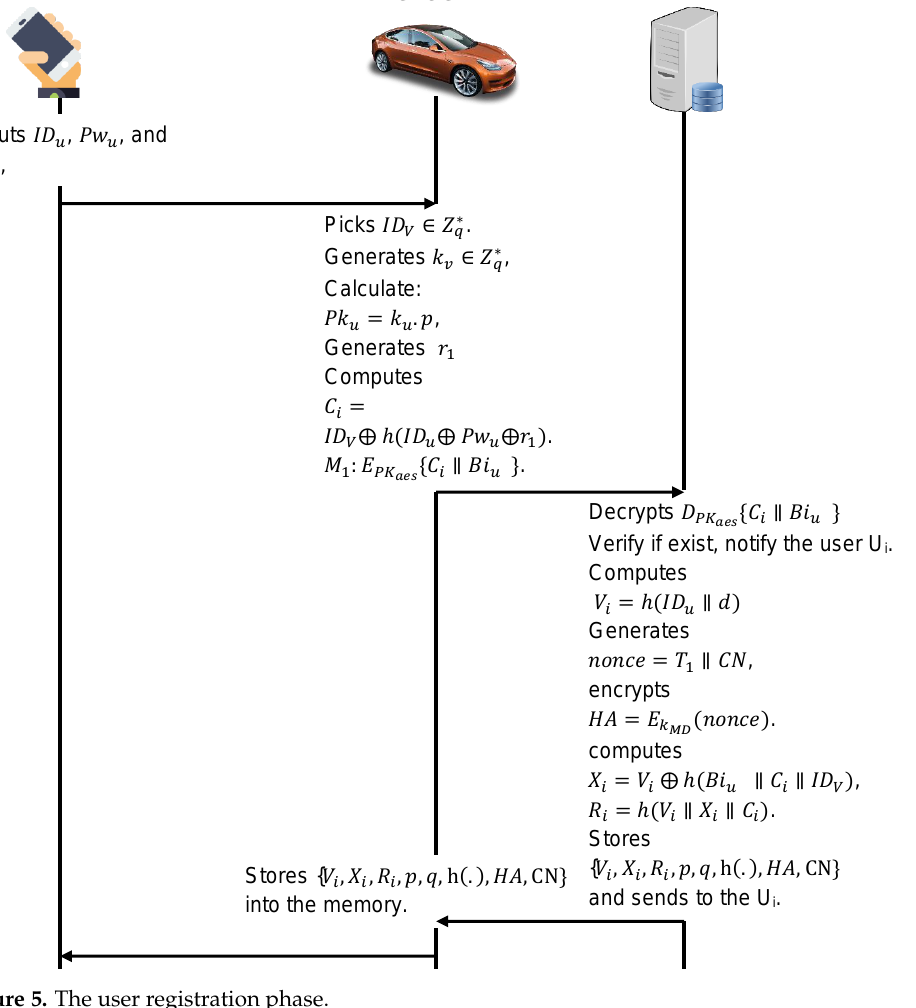
Figure 5. The user registration